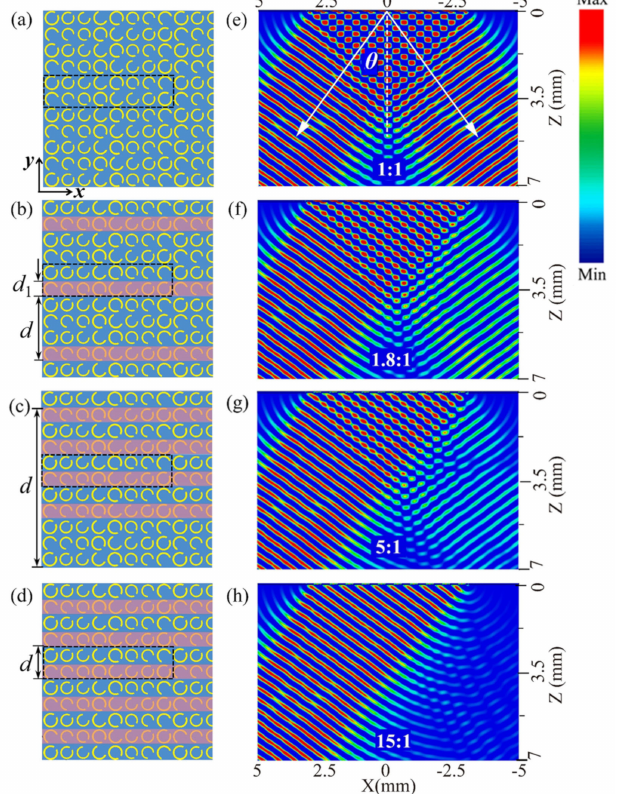
Figure 3. ( a – d ) Partial sketches of the designed metasurface with the red stripe patterned illumination. The dashed frames denote the basic unit cells. ( e – h ) Simulated electric field distributions of beam splitting in the corresponding illuminated patterns at 0.8